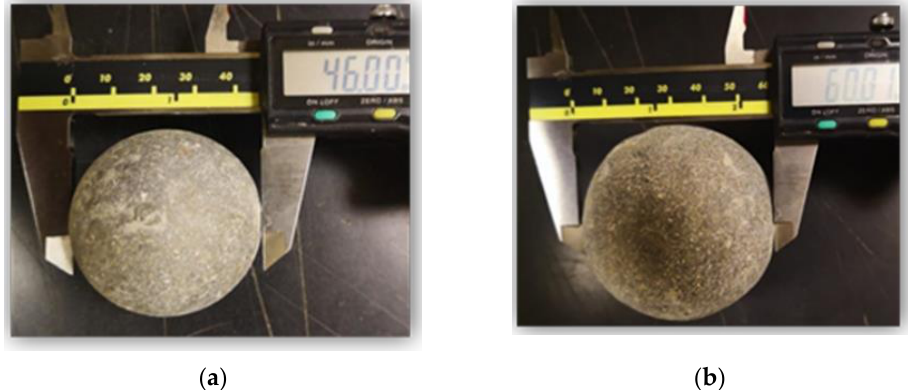
Figure 4. Steel balls employed in the LA abrasion treatment: ( a ) 46 mm (standard); ( b ) proposed diameter of 60 mm.